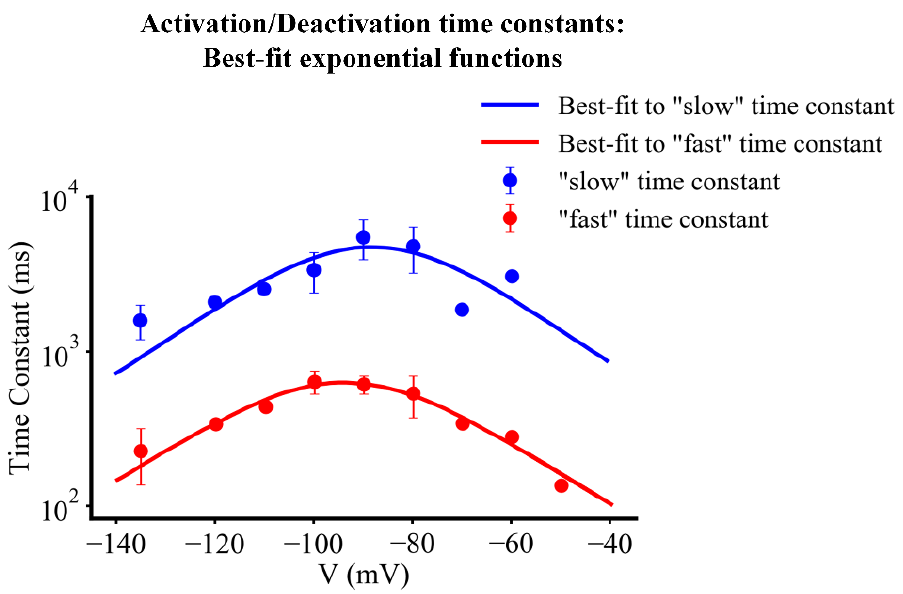
Figure 6. Plots of the voltage dependence for both the slow and the fast kinetic processes that underlie the activation and deactivation of I f . As indicated in the inset, data depicting the fast time constant for I f kinetics is shown in red while data based on the determination of the slow time constant at each membrane potential is shown in black. Activation and deactivation time constants obtained at the same membrane potential have been pooled to form each of these plots. Details about the fit functions for the fast and slow time constants are given in Equations (S5) and (S6) in the Supplementary Materials.